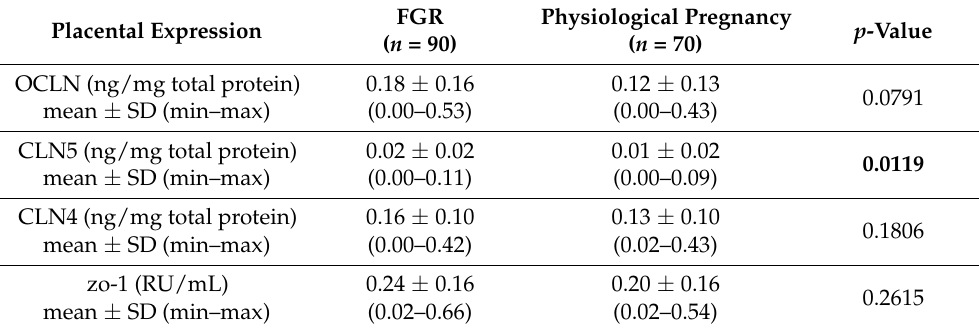
Table 4. Placental expression of tight junction proteins in pregnancies complicated by fetal growth restriction (FGR) and physiological